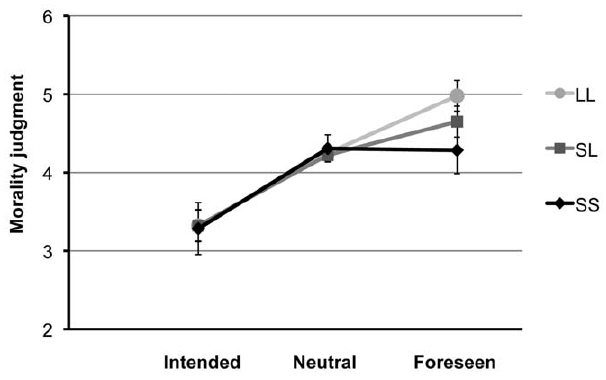
Figure 1. Mean judgments of the moral acceptability of intended, neutral, and foreseen harm by 5-HTTLPR genotype. Error bars denote standard error. Acceptability judgments of foreseen harm scenarios varied linearly with